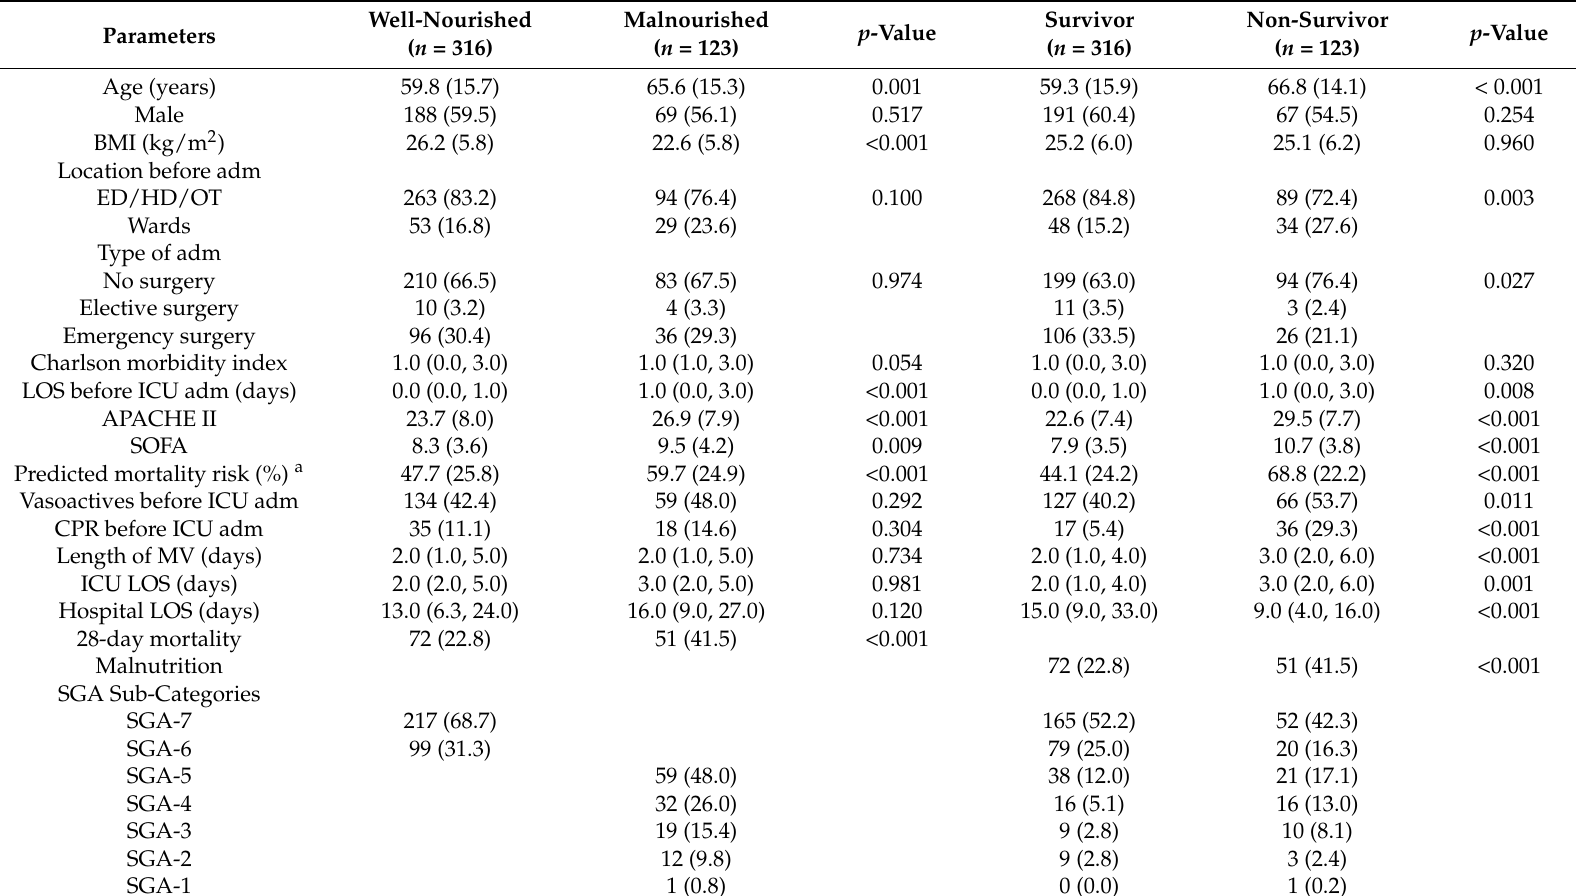
Table 1. Comparison of characteristics between well-nourished and malnourished patients, and 28-day survivors and non-survivors.